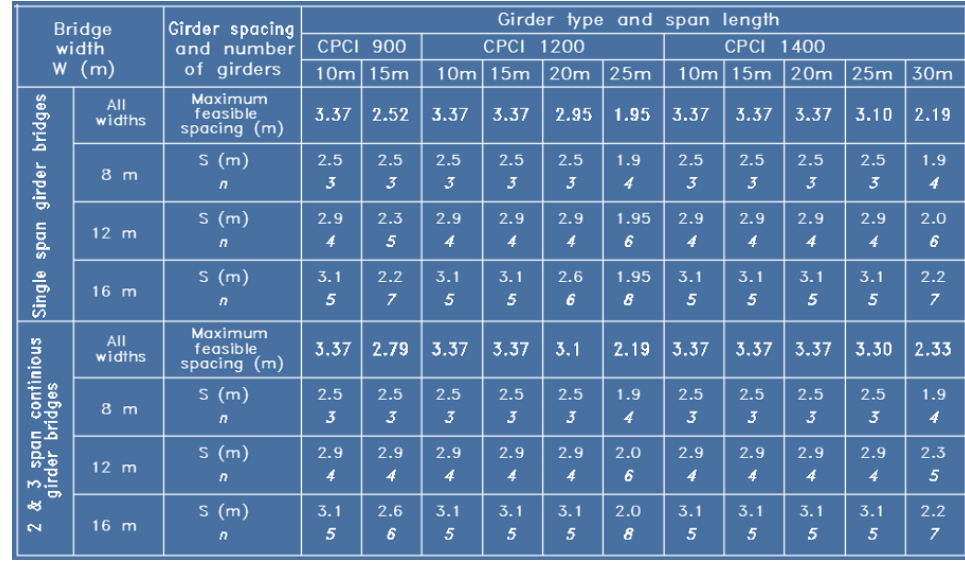
Figure 3. Maximum feasible girder spacing, optimum girder spacing and optimum number of girders for single, two and three-span continuous CPCI girder bridges. Z. Lounis and M.